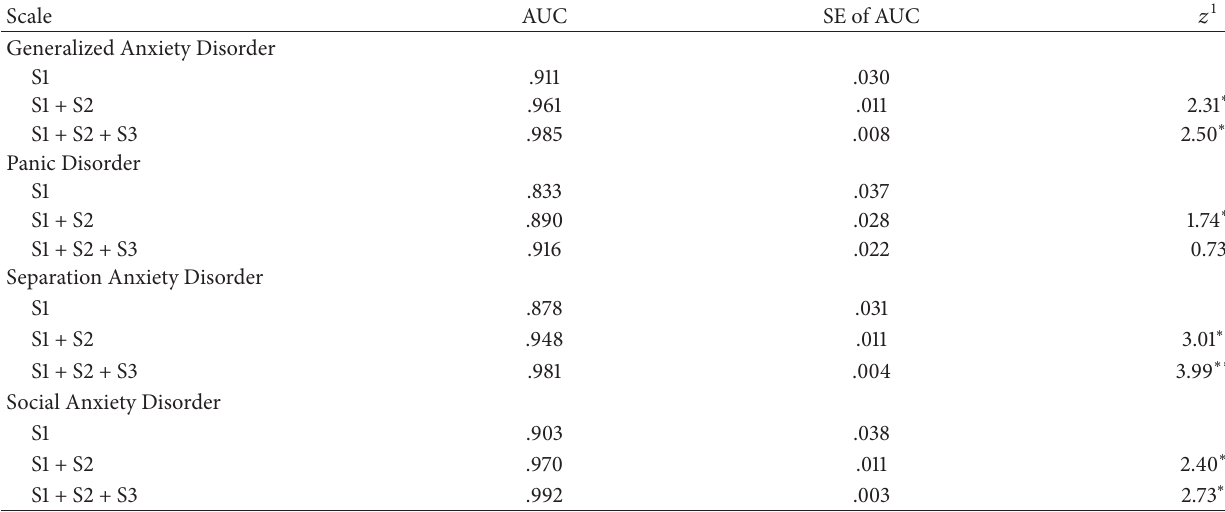
Table 1: Summary statistics of ROC